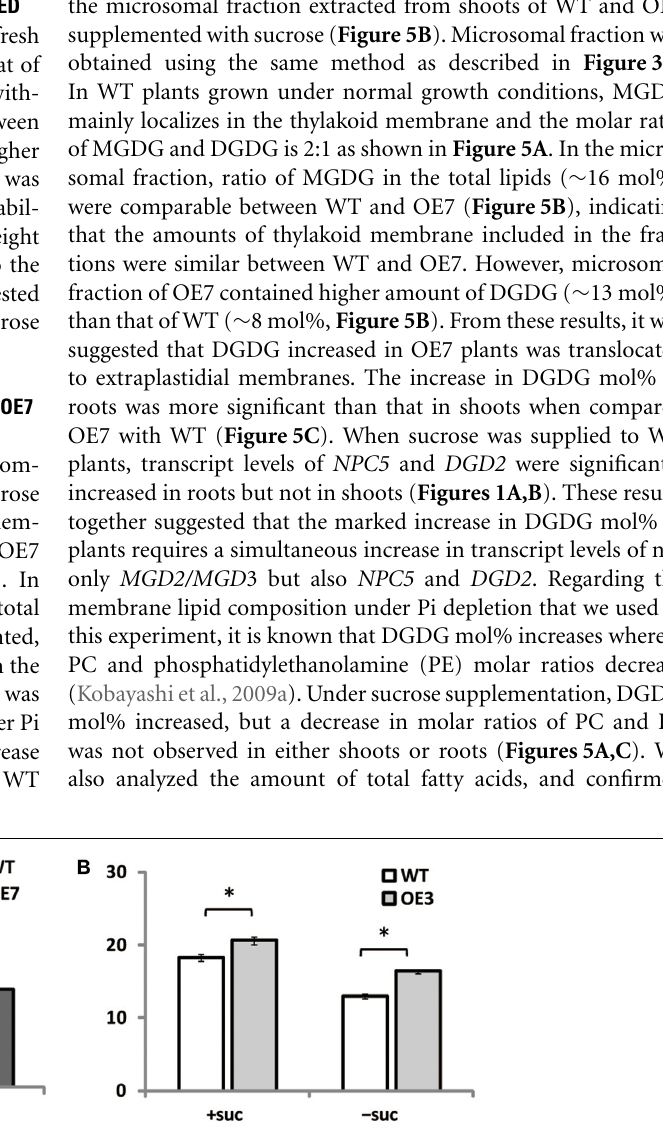
another 7d. Shoot fresh weight of OE7 (A) and OE3 (B) . Root fresh weight of OE7 (C) and OE3 (D) . Values represent the mean ± SE ( n = 12 groups of 3–5 plants for OE7 shoots, n = 6 groups of 3–5 plants for OE7 roots, and n = 20 groups of 3–5 plants for OE3 shoots and roots). ∗ P < 0 .